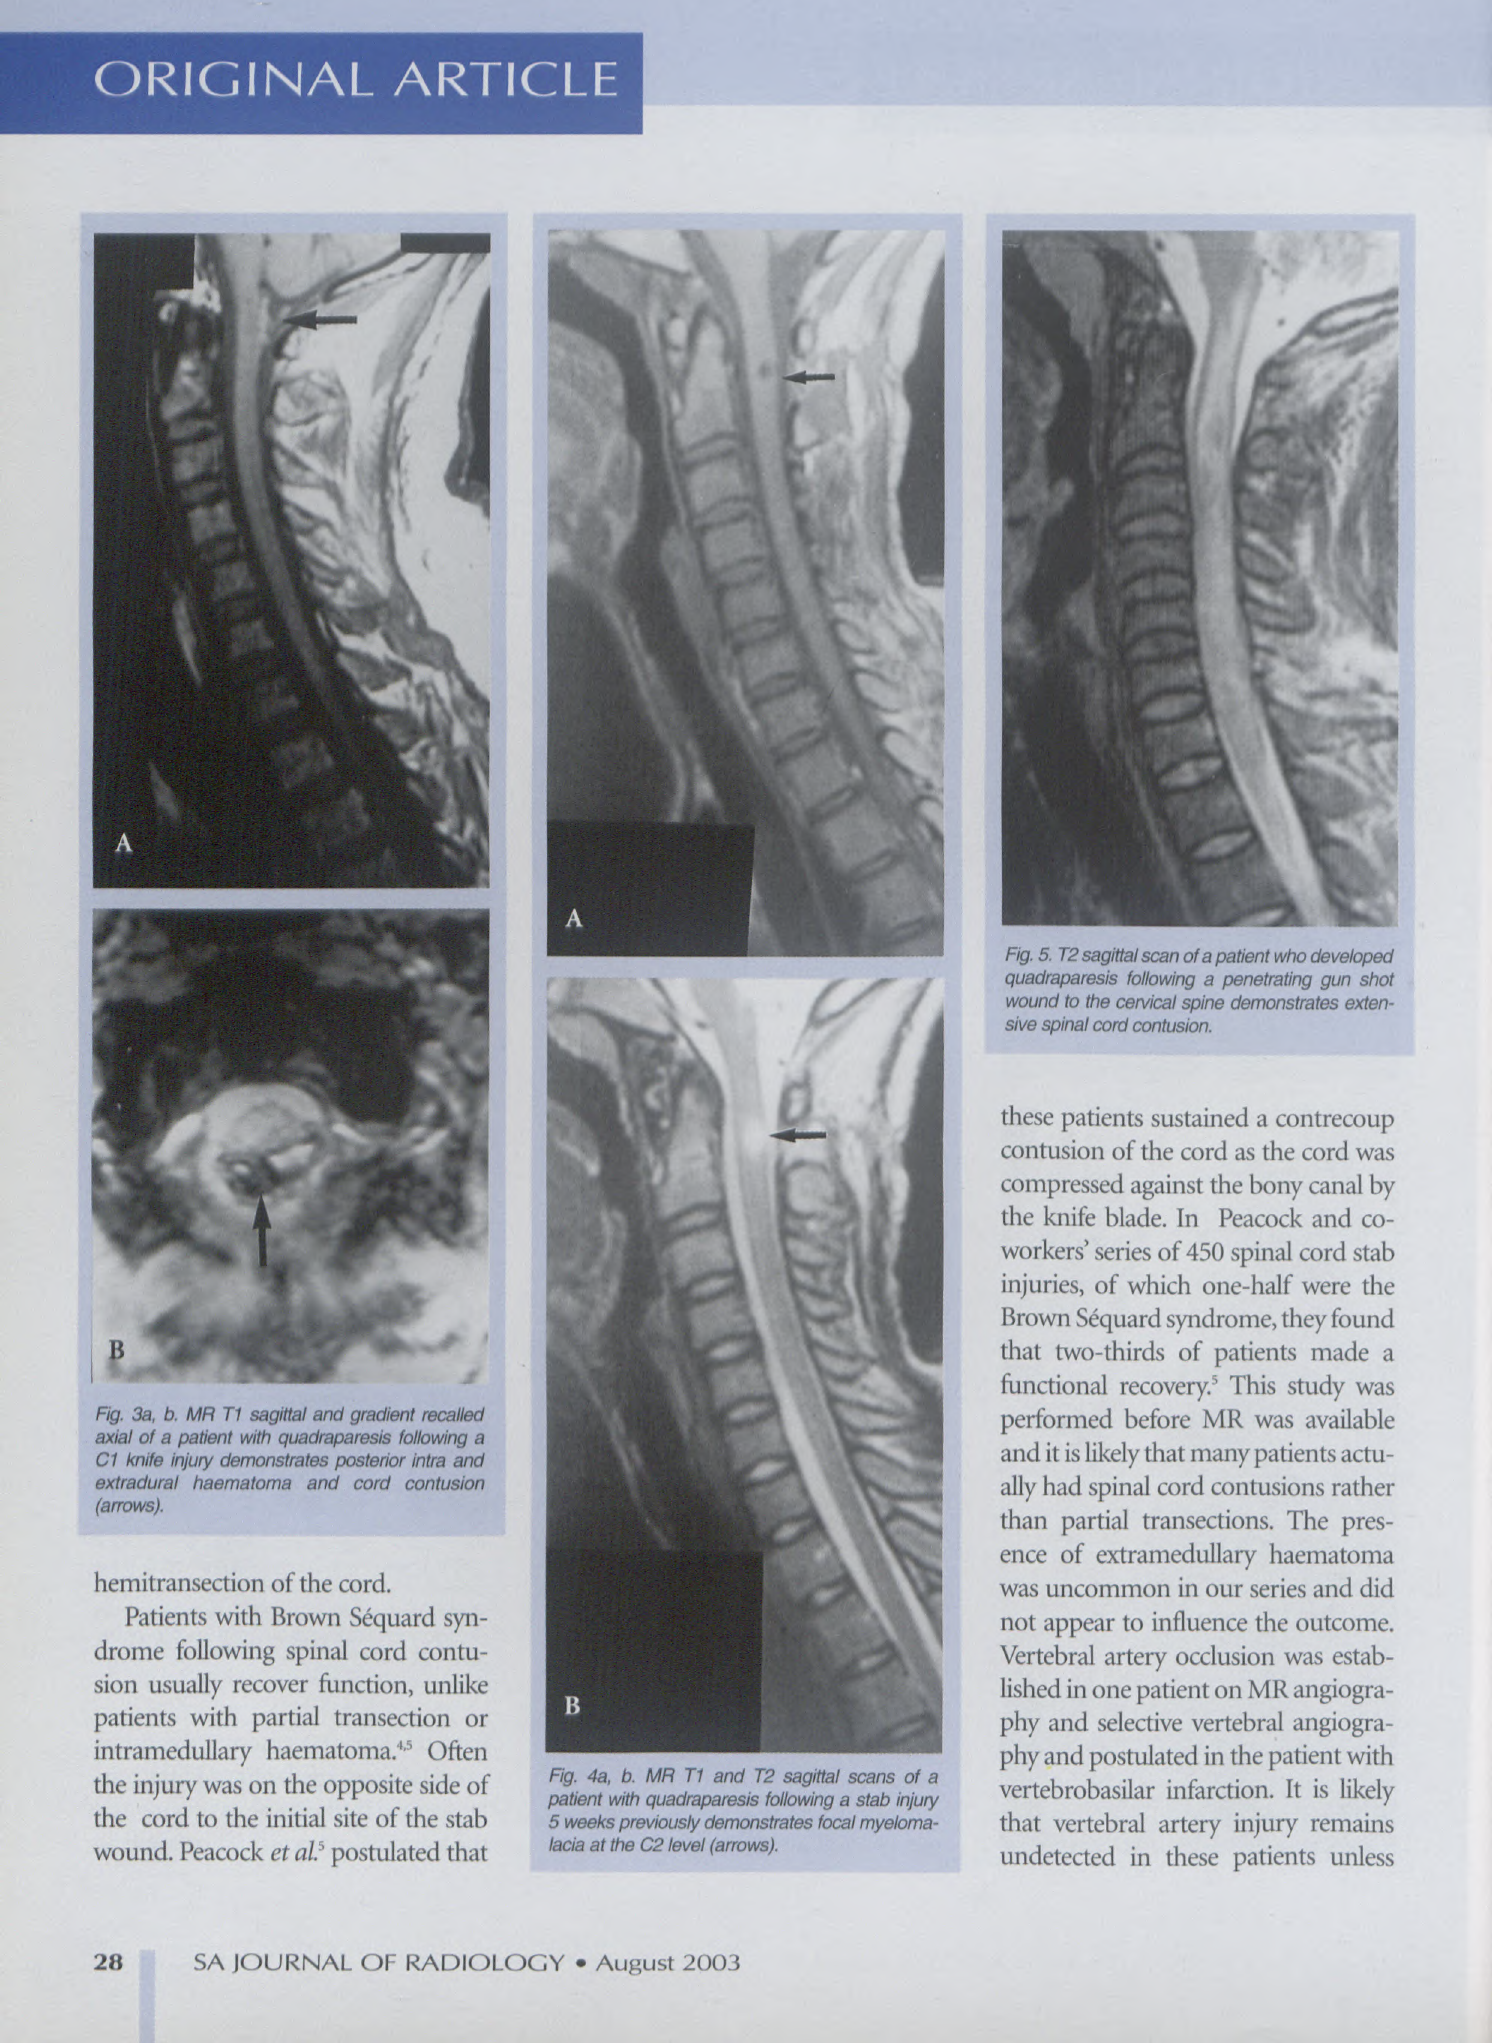
Fig. 4a, b. MR T1 and T2 sagittal scans of a patient with quadraparesis following a stab injury 5 weeks previously demonstrates focal myeloma- lacia at the C21evel (arrows).